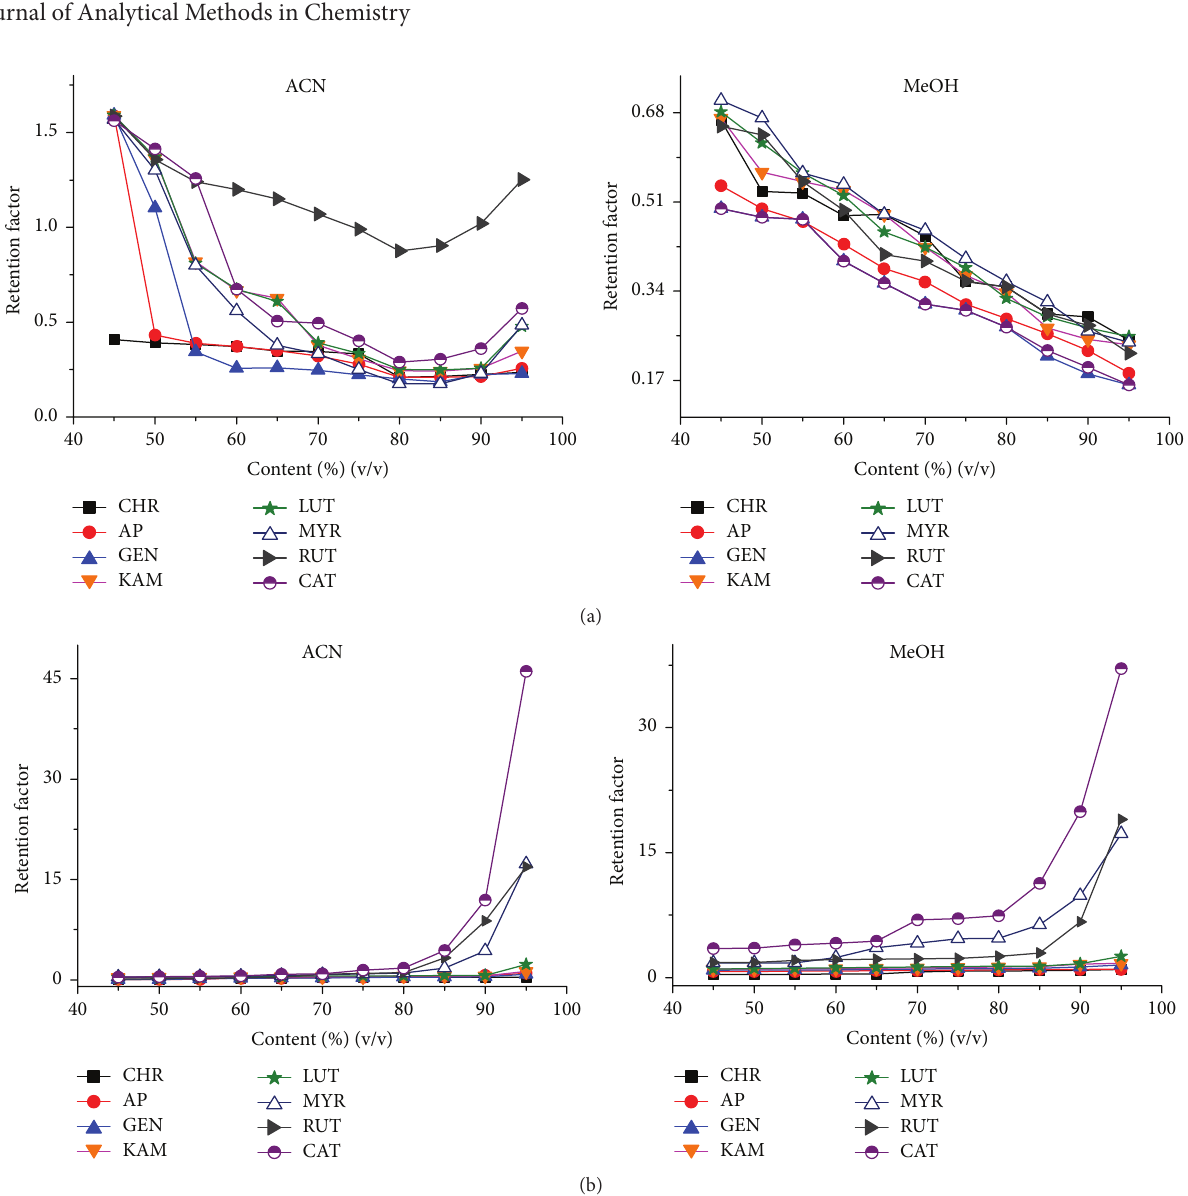
the ionization state of the analytes. The p 𝐾 𝑎 values of our analytes are in range of 6.4–7.1. Thus at pH 7.0 they exist in the equilibrium between the charged and the neutral forms. The obtained retention factors were plotted against the organic solvent content in the range of 40–95% (v/v) as shown in Figure 1. The higher content of both applied organic solvent in the mobile phase enhances the retention of studied flavonoids on ZIC-HILIC column. At increasing concentration of ace- tonitrile, water is adsorbed more strongly on the surface of the polar stationary phase. The more hydrophilic the analytes are, the more the partitioning equilibrium is shifted towards the adsorbed water layer on the stationary phase, and the more analytes are retained. It can be clearly seen on